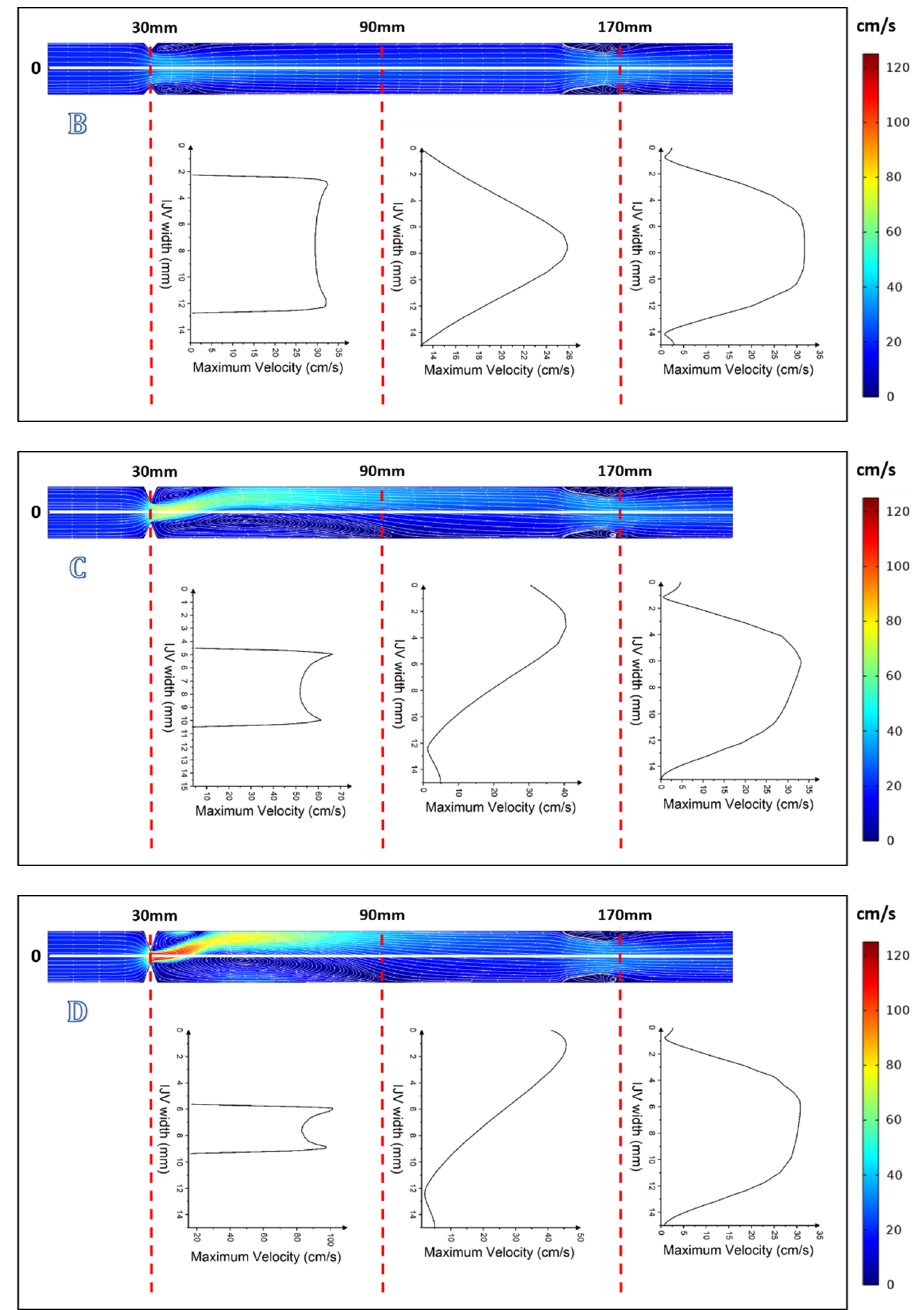
Figure 6. Graphical representation of flow with velocity profiles at t = 3 s: ( A ) without upstream stenosis; ( B ) with 30% upstream stenosis; ( C ) with 60% upstream stenosis; and ( D ) with 75% up- stream stenosis.